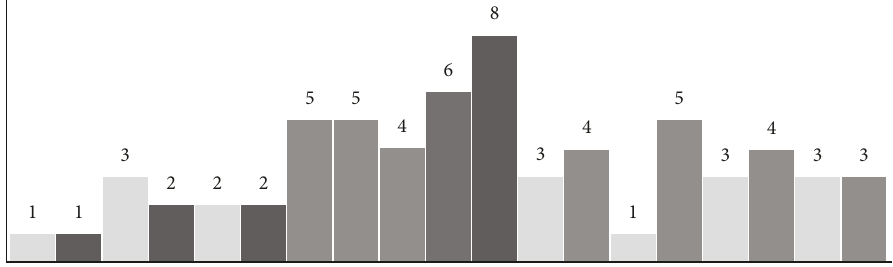
Figure 3: Number of articles published yearly.